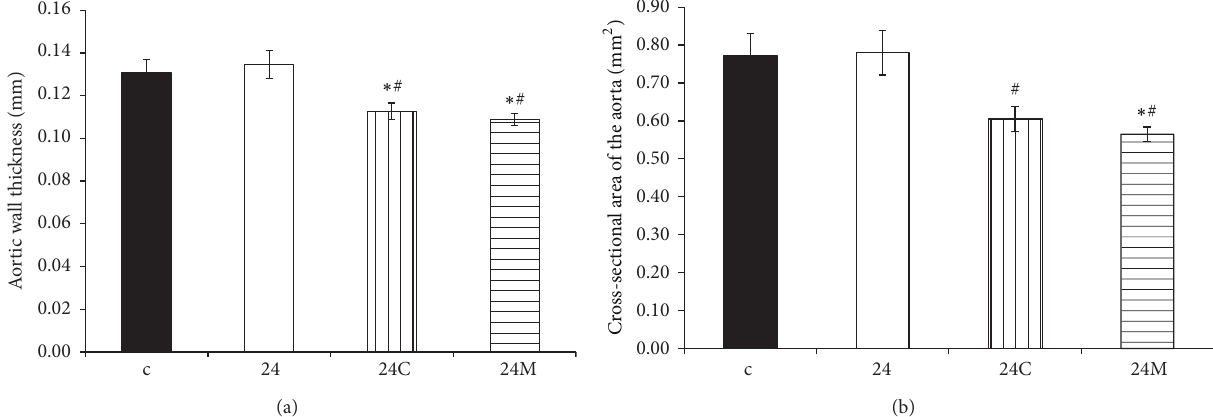
Figure 2: The influence of captopril (24C) and melatonin (24M) on wall thickness (a) and cross-sectional area (b) of the aorta in 24 hours/day continuous light exposure-induced hypertension (24). c: Wistar controls. ∗ 𝑃 < 0.05 versus c; # 𝑃 < 0.05 versus 24.